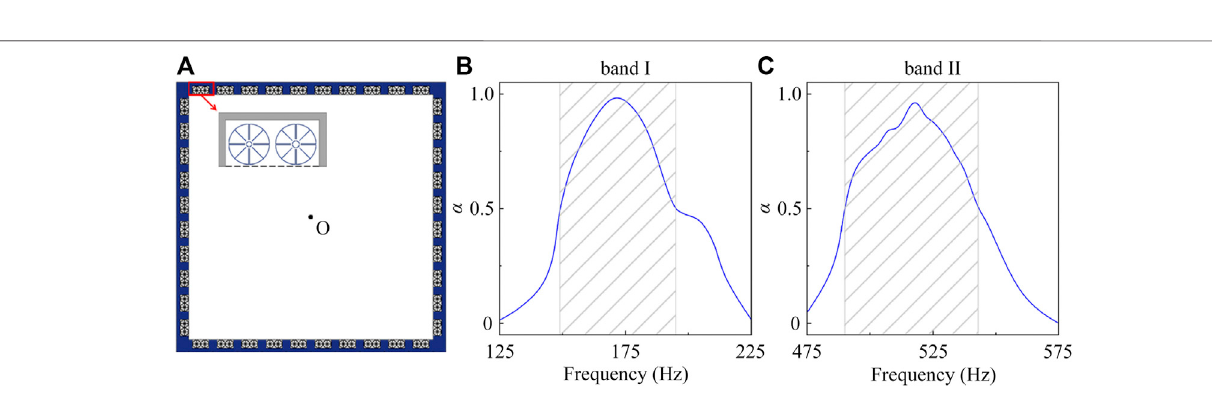
FIGURE 3 | Simulated absorption spectra of the unit cell in the bands (A) I and (B) II with the incident angle θ = 0 ° , 45 ° and 60 ° .